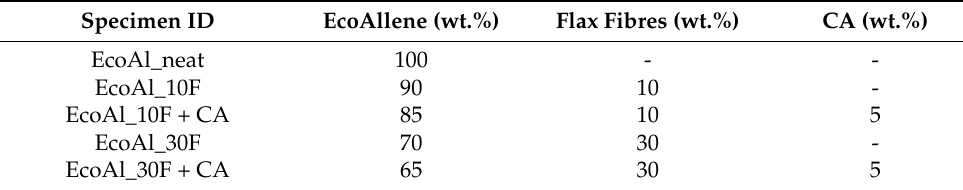
Table 1. List of all EcoAllene-based